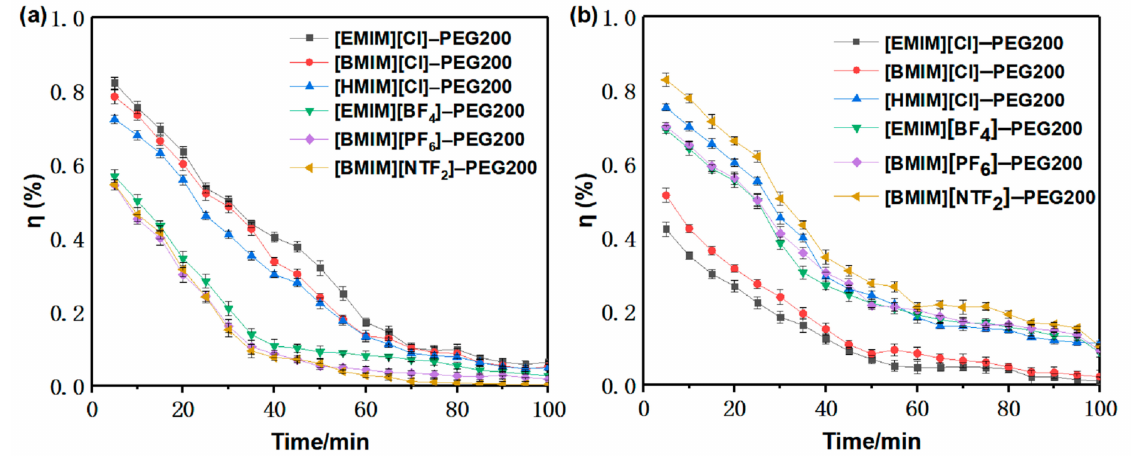
Figure 1. The influence of different complex absorbents on the absorptivity for ( a ) DCM and ( b ) benzene